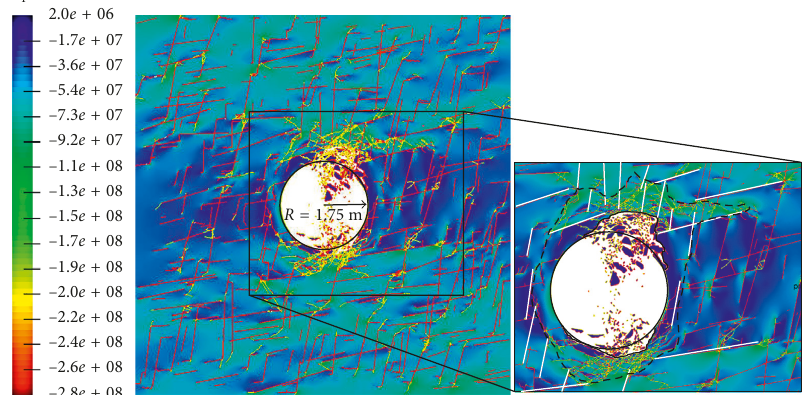
Figure 16: Major principal stress σ 1 contours of the fractured FDEM model. Cohesive elements failing in tension (Mode I fractures) are coloured red, and cohesive elements failing in shear (Mode II fractures) are coloured yellow. The dashed black line indicates the damage profile based on the monitored fractures. The continuous black line indicates the collapsed material. White lines indicate the contributing joints to the obtained damage profile.